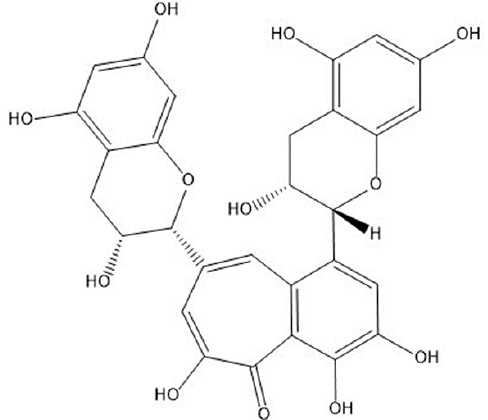
Figure 1. Chemical structure of theaflavin ( TF).